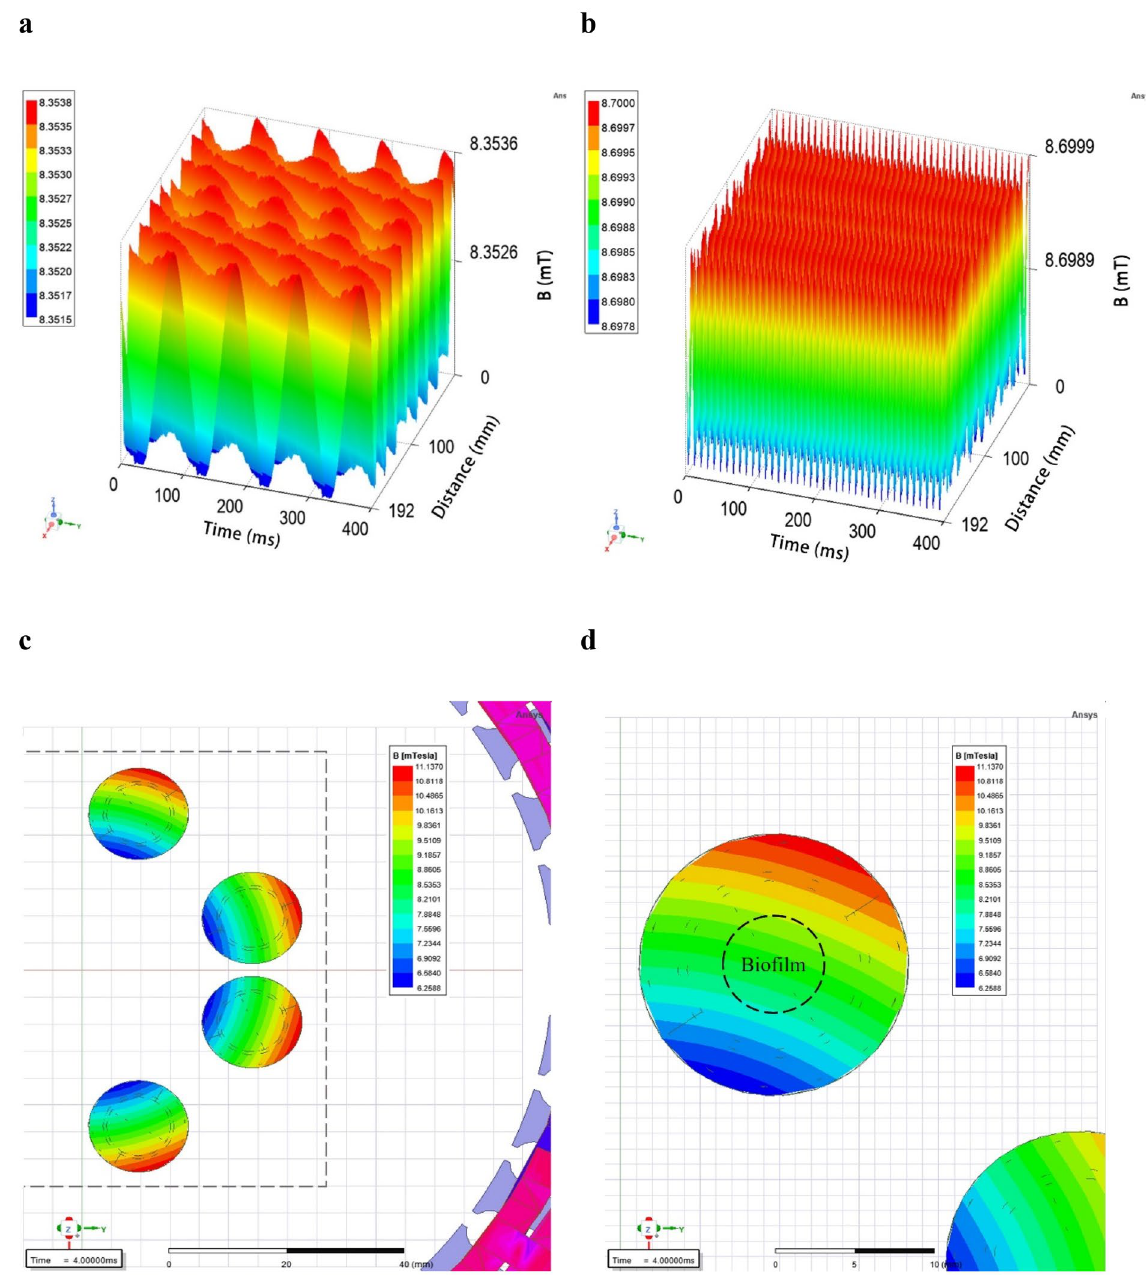
Figure 10. Periodical changes in magnetic induction in the center of the well of a test plate depending on the applied current frequency: ( a ) 5 Hz; ( b ) 50 Hz and distribution of the magnetic induction: ( c ) in the wells of a test plate; ( d ) at the location of the agar disc covered with